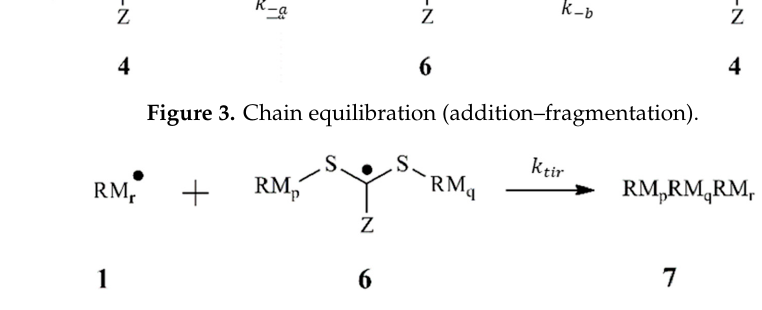
Figure 4. Intermediate radical termination (IRT).